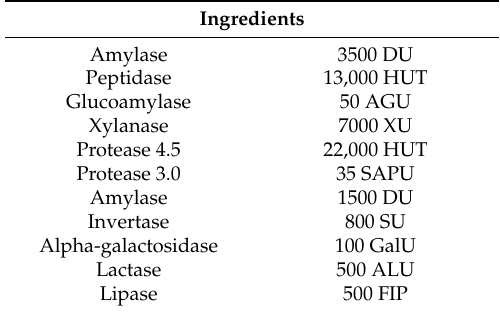
Table 3. Digestive Enzyme Ingredients (1